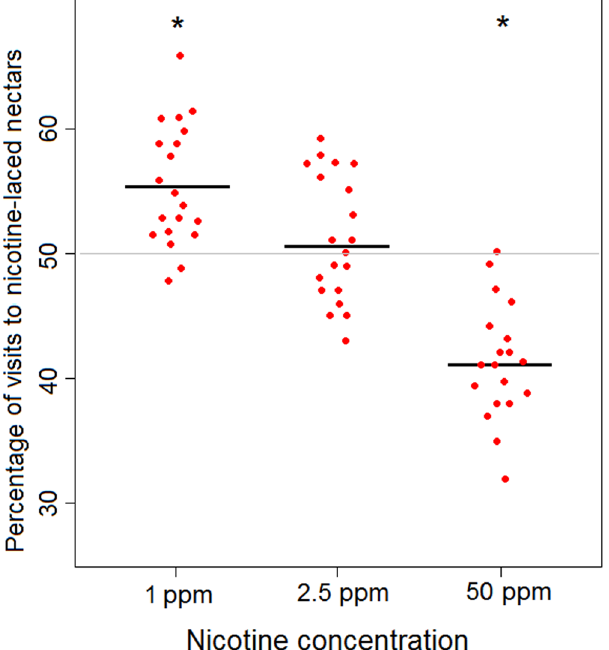
Figure 1. Bumblebee preference for nicotine-enriched nectars. Individual preferences (mean value of 100 choices) of bees ( n = 60, 20 each nicotine concentration) for the flower type associated with nicotine- laced sucrose solution during a foraging choice test. Bees are deterred only by unnaturally high nicotine concentrations (50-ppm). This deterrence disappears or turns into attraction at lower nectar-relevant concentrations (1 and 2.5-ppm). Red dots represent individual bees, while the black bars indicate the mean value for each group. The grey line indicates random choice level. * P =